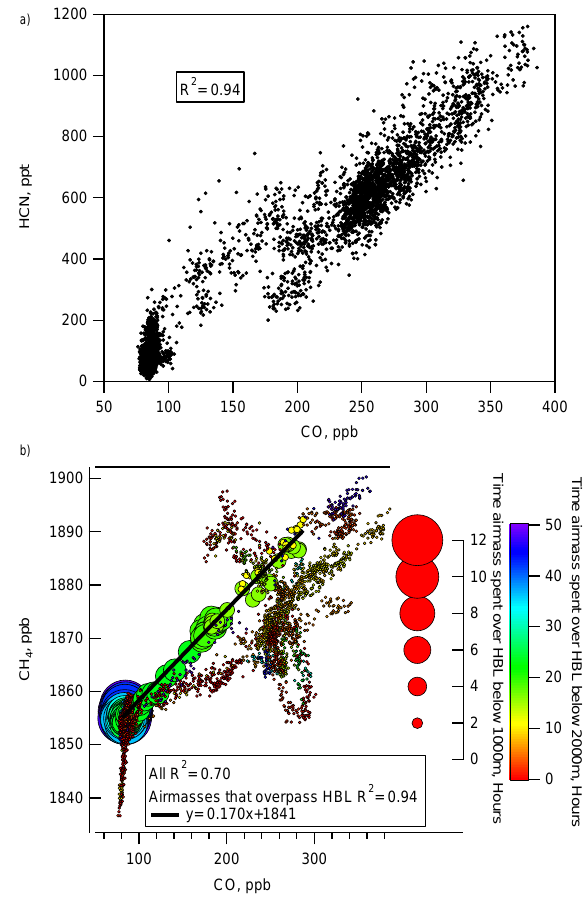
Fig. 10. Tracer–tracer relationships for a BB plume sampled during flight B624. Plot (b) , showing the relationship between CH 4 and CO, has been colour-coded and sized according to the length of time the HYSPLIT trajectories spent over wetlands near Hudson Bay